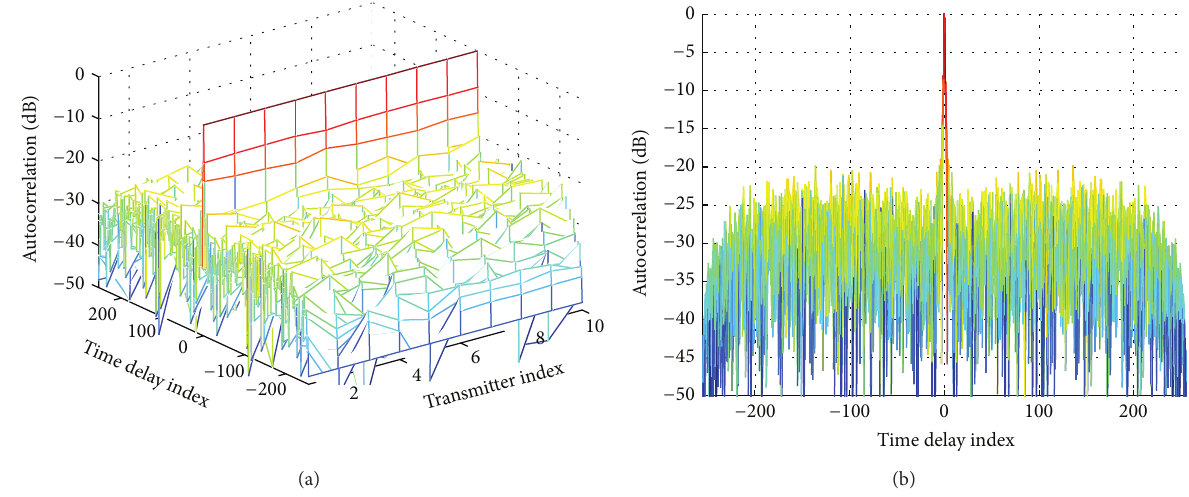
Figure 7: 𝑀 radar waveforms’ autocorrelation function: (a) perspective view; (b) front projection.